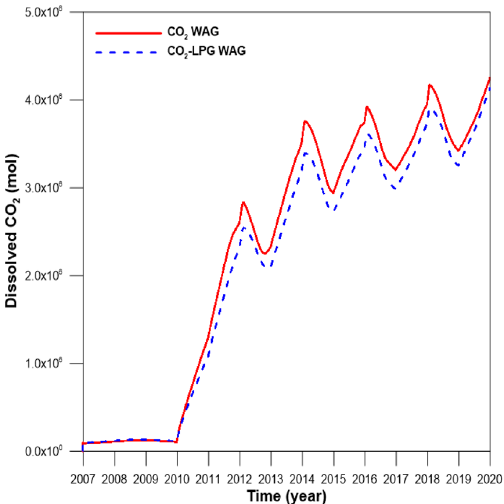
Figure 12. The amount of dissolved CO 2 for CO 2 and CO 2 -LPG WAG injection.